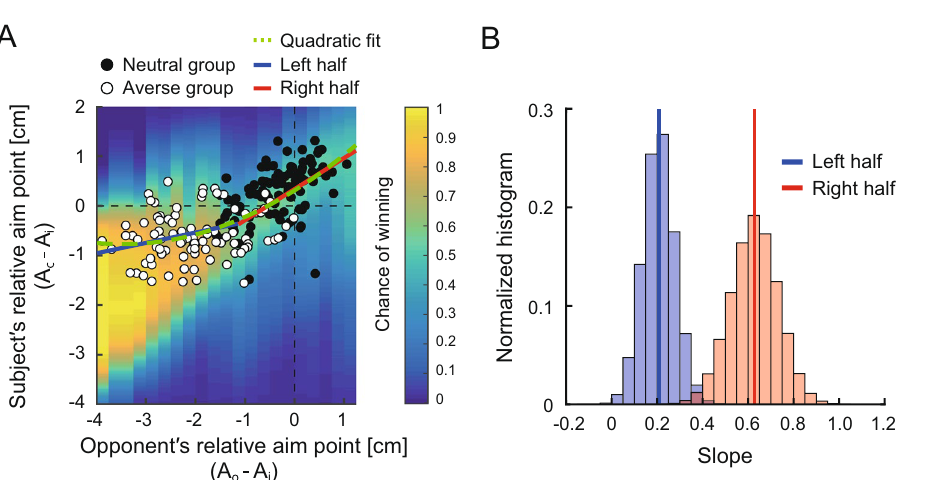
Figure 6. Non-linear influence of opponent’s decisions on subject’s decisions. ( A ) Aim point modulation as a function of the opponents’ relative aim points. The subjects’ relative aim point (mean endpoint in the competitive task A c - mean endpoint in the individual task A i ) is plotted against the opponents’ relative aim point (mean endpoint of the opponent A o − A i ). Black circles indicate the actual data of the risk-neutral group (11[2nd–12th] blocks × 9 subjects), and white circles indicate that of the risk-averse group (11[2nd–12th] blocks × 8 subjects). The slope of regression line in the left (blue) and right (red) halves of the plot predicted the non-linear influence of the opponents. The green dashed line shows a quadratic curve fitted to the data ( Y = 0.625 X + 0.009 X 2 + 3.17). A color bar denotes the chance of winning when the aim point data falls within a particular region. ( B ) Histogram of bootstrapped slopes of regression line (50,000 repetition). Vertical lines indicate the mean values of each distribution. Permutation tests revealed a significant difference between the slopes of regression lines, suggesting a smaller influence of the opponents’ decisions on the subjects’ decisions in the left half of the plot than in the right